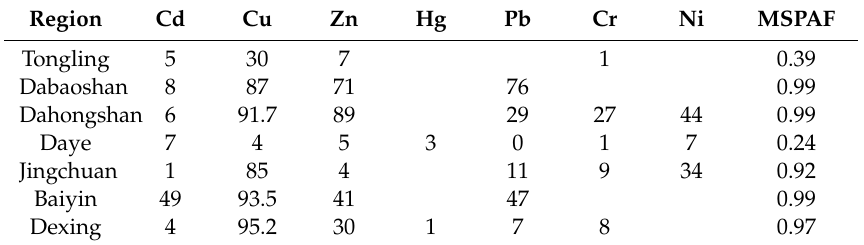
Table 5. Potential hazard ratio (PAF) and composite hazard ratio (MSPAF) of each heavy